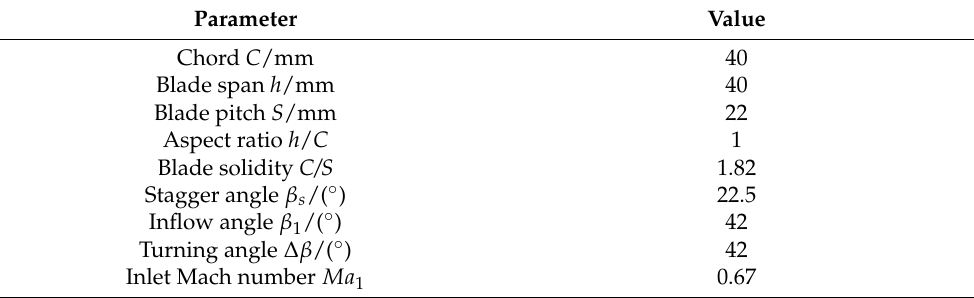
Table 1. Original cascade design